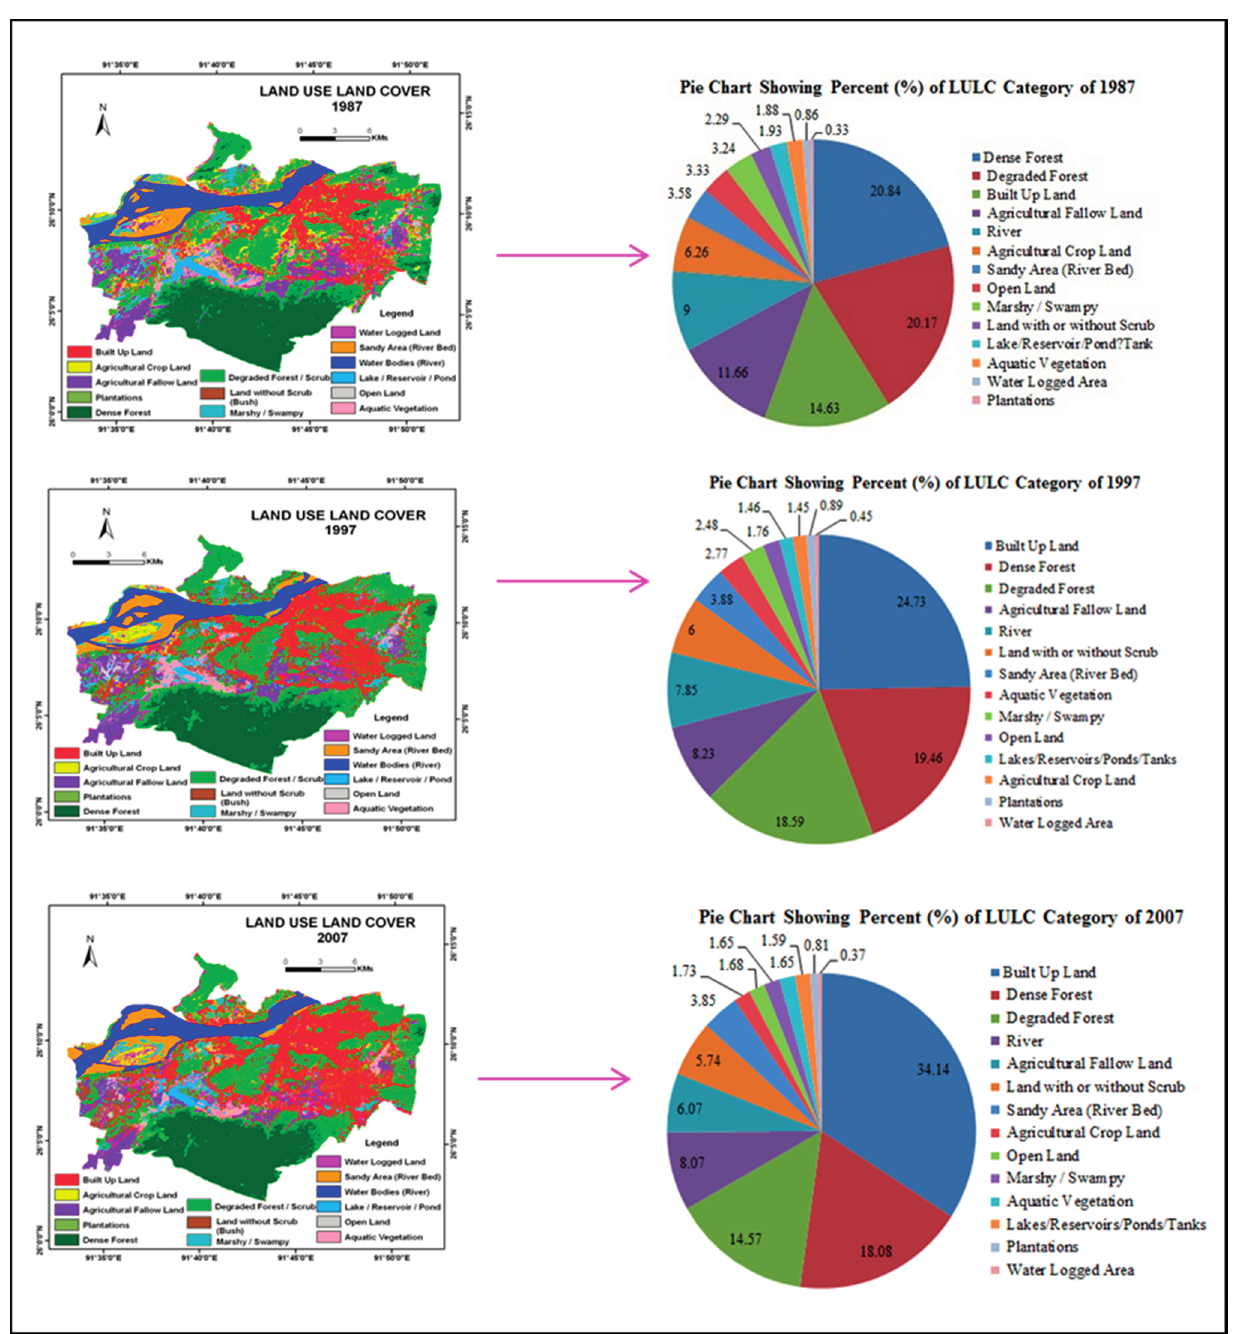
Figure 4. Allocation of LULC and percent (%) of LULC of 1987, 1997 and 2007 [9]. LULC map of 1997 shows that nearly 102.4 km 2 (24.73%) of the study area is covered by built up land followed by dense forest 80.56 km 2 (19.46%), degraded forest 76.95 km 2 (18.59%), agricultural fallow land 34.08 km 2 (8.23%), river/stream 32.51 km 2 (7.85%), land with or without scrub 24.82 km 2 (6%). If we look carefully at built up area, it is the highest area occupied class in 1997 dense forest 80.56 km 2 (19.46%) followed by degraded forest 76.95 km 2 (18.59%). But if we look carefully combined dense forest and degraded forest as forest land, it is 157.51 km 2 (38.05%) and is